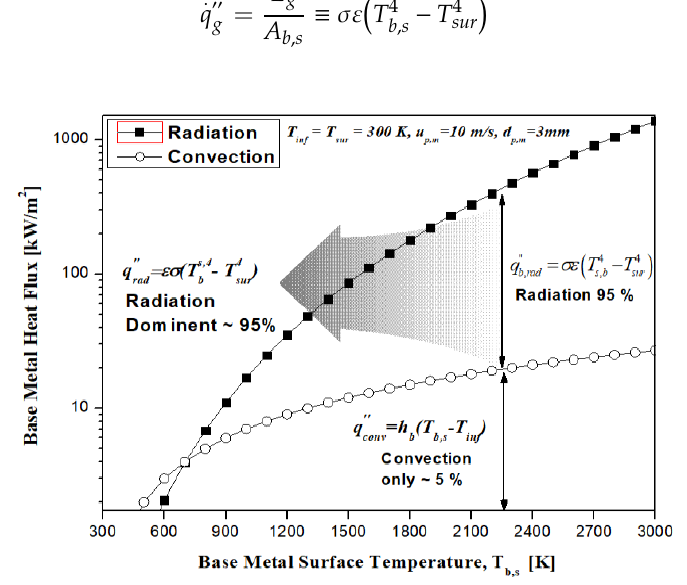
Figure 6. Comparison of the convection and the radiation of the base metal.